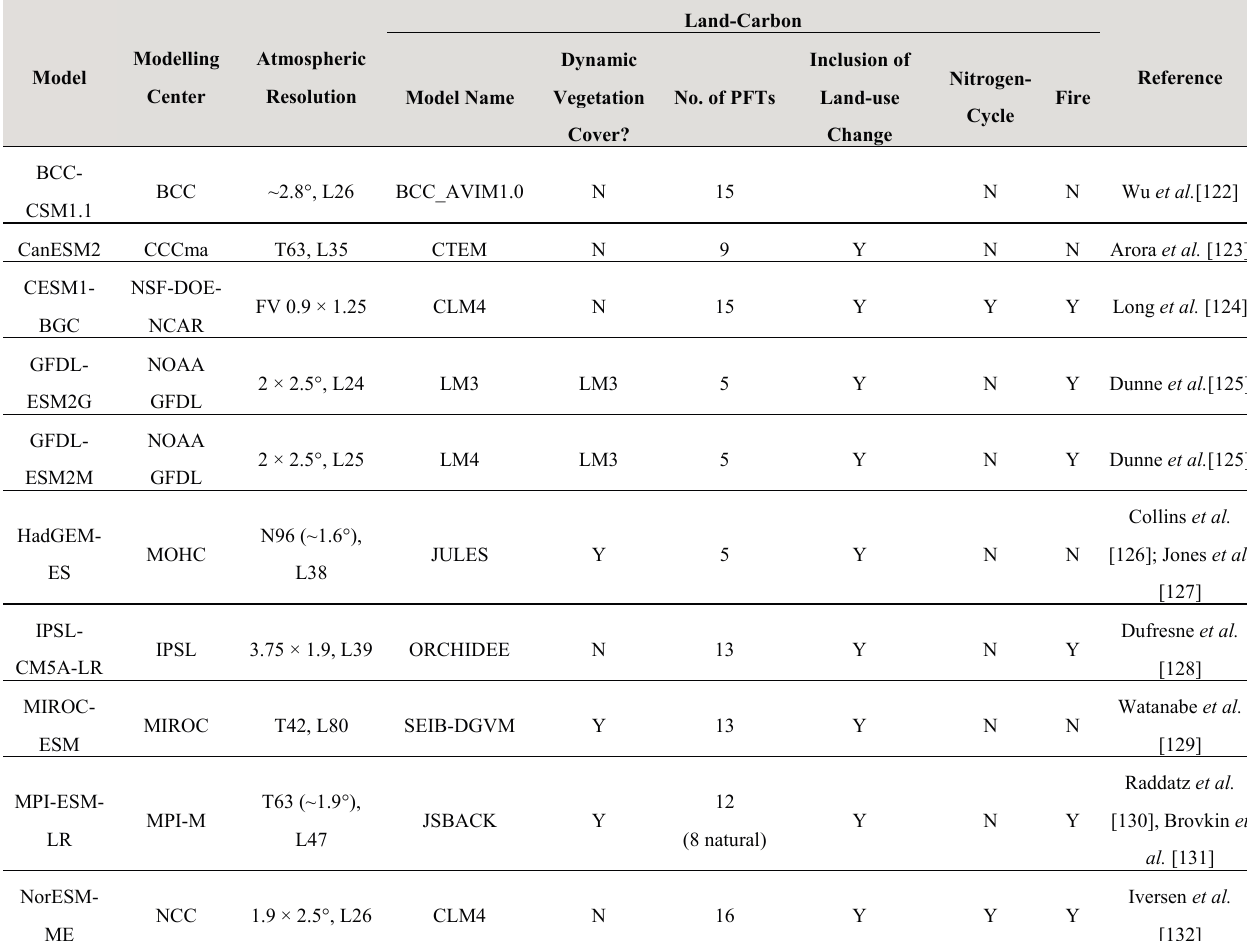
Table 5. Characteristics of coupled climate models. Source: Own Elaboration from Table 6.11 in IPCC AR5 preliminary documents